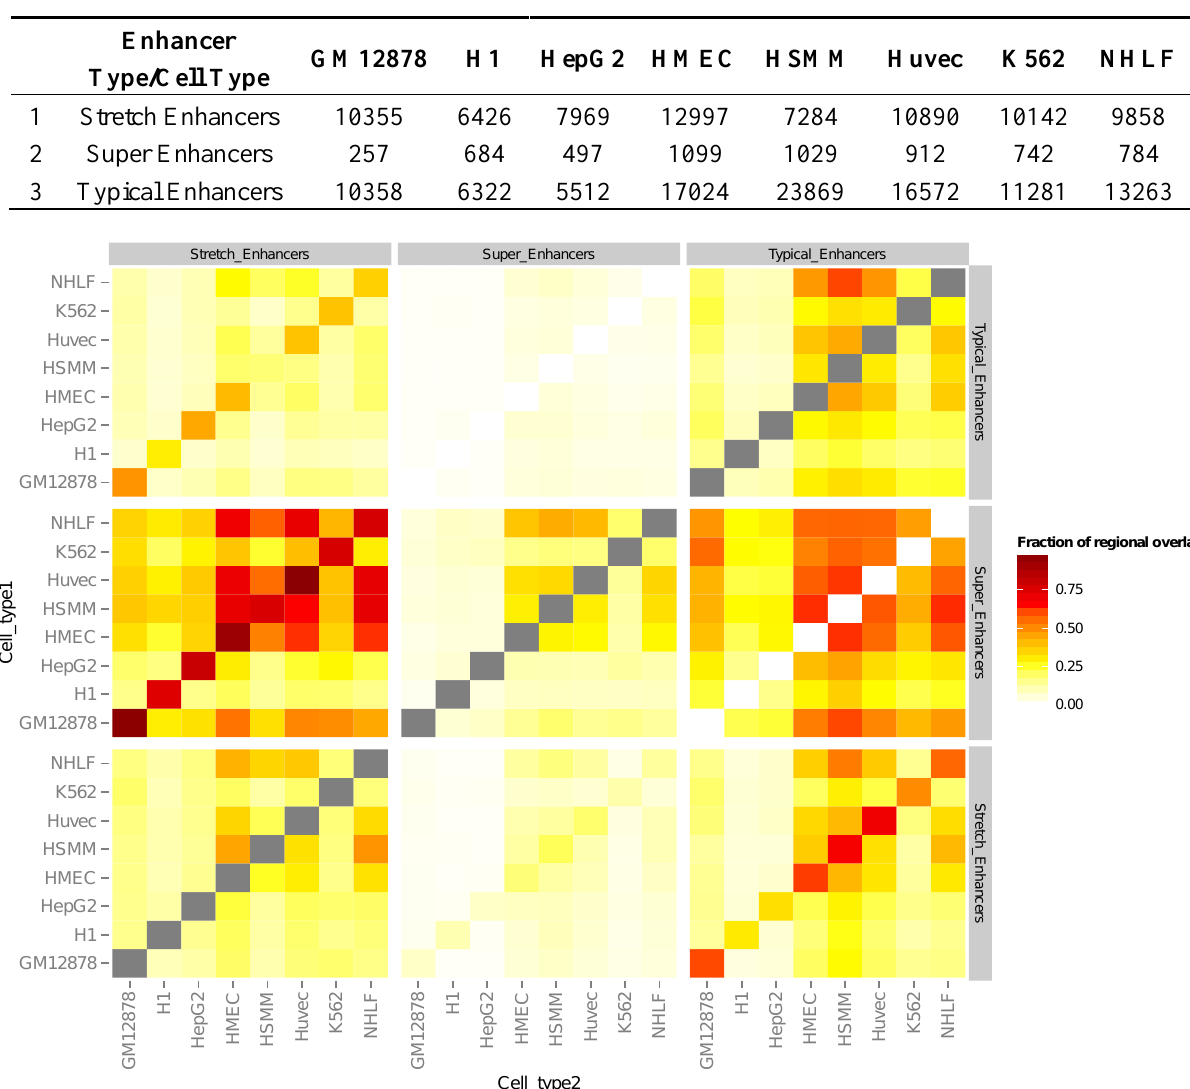
Table 2. Number of stretch [20], super and typical enhancers [10] reported in eight matched cell types.